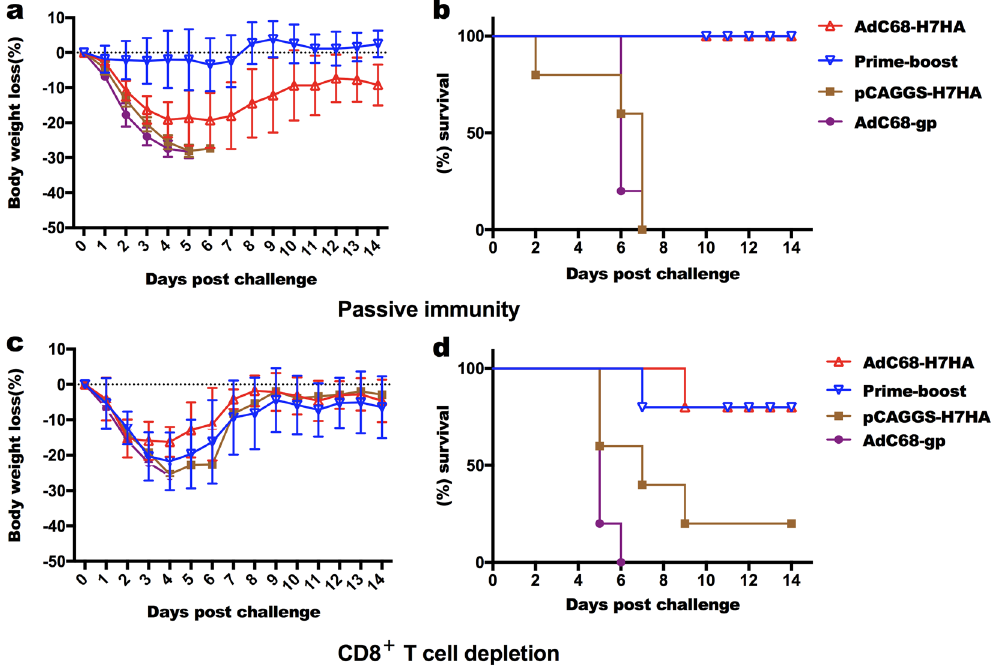
Figure 6. H7N9 HA-specific antibody and HA-specific CD8 + T cells cooperate to protect mice from lethal H7N9 viral challenge. Twenty 12-week-old female C57BL/6 mice were divided into 4 groups. The mice in each group passively received 1 mL of serum derived from immunized mice 24 hours before infection with lethal H7N9 virus. The mice in the AdC68-H7HA group and prime-boost group showed 100% protection and significant differences in body weight and survival when compared with those in the DNA-only group and the AdC68-gp group. ( a ) Body weight changes following passive immunity. ( b ) Survival rates following passive immunity. Twenty 6-week-old female C57BL/6 mice were divided into 4 groups: AdC68-H7HA group, pCAGGS-H7HA group, AdC68-gp group, and prime-boost group. At 8 weeks after immunization, mice were injected with an anti-CD8 antibody at 3 and 1 day before challenge and 1 day after challenge. Body weight changes and survival rates were monitored for 14 days. ( c ) Body weight changes after depletion of CD8 + T cells in vivo . ( d ) Survival rates after depletion of CD8 + T cells in vivo